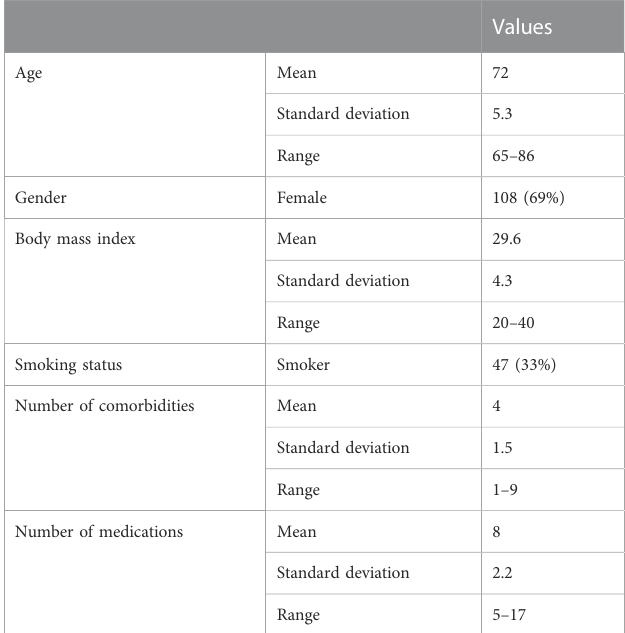
TABLE 1 Participants ’ characteristics and descriptive statistics (N =